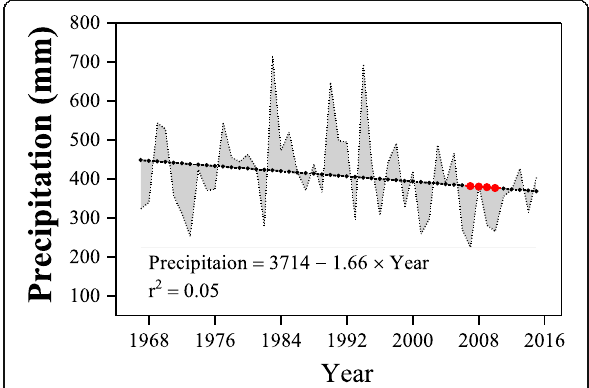
Fig. 2 Long-term change in annual precipitation and its trend in Songnen meadow steppe during the past 49 years (1967 to 2015)